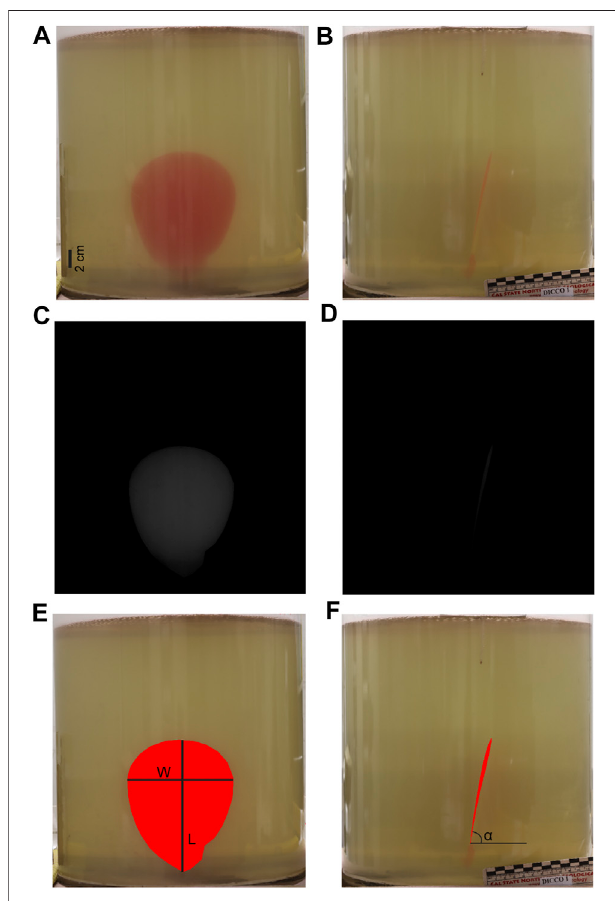
FIGURE 1 | Experiment “ Dike 1 ” at time (cid:1) 190 s. Front and lateral view (Panels A,B ). Black and gray images (Panels C,D ). Estimated values (Panels E,F ). α is the dip of the